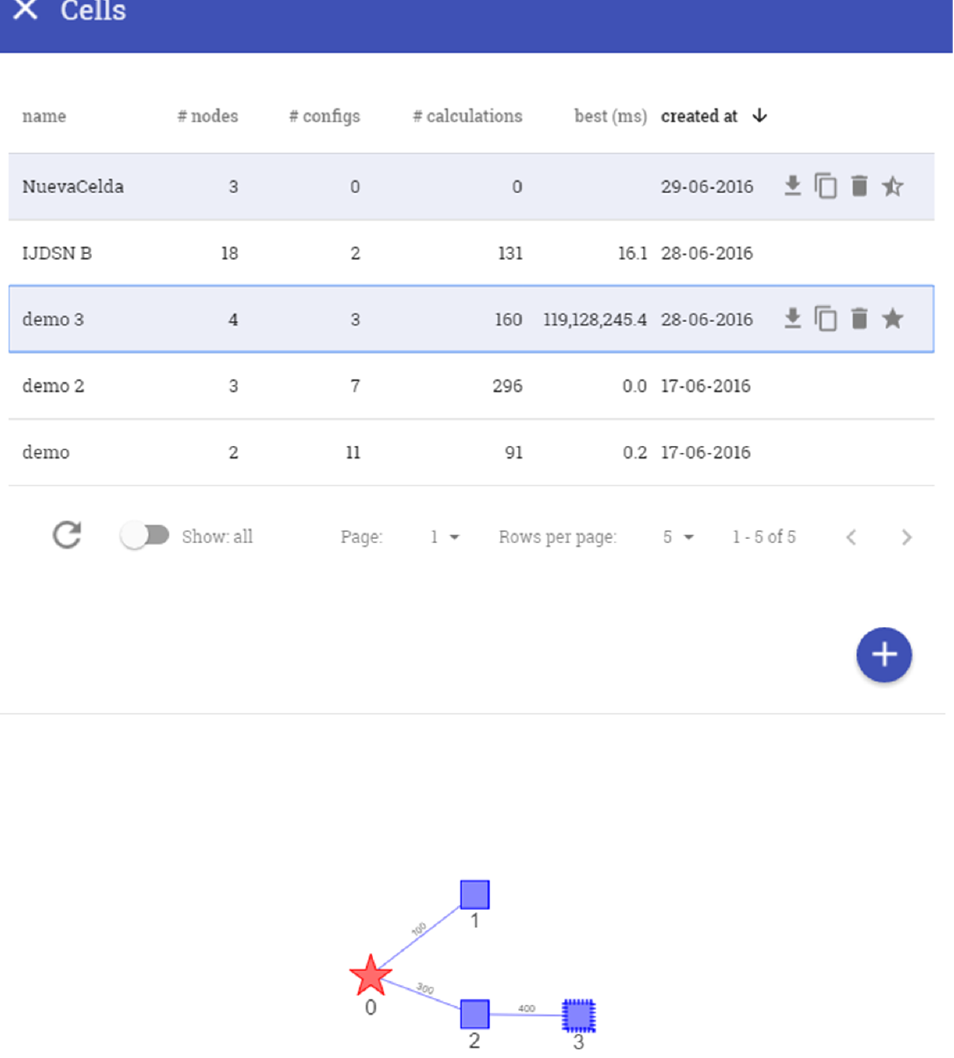
Figure 12. Example of list of cells created by the user.